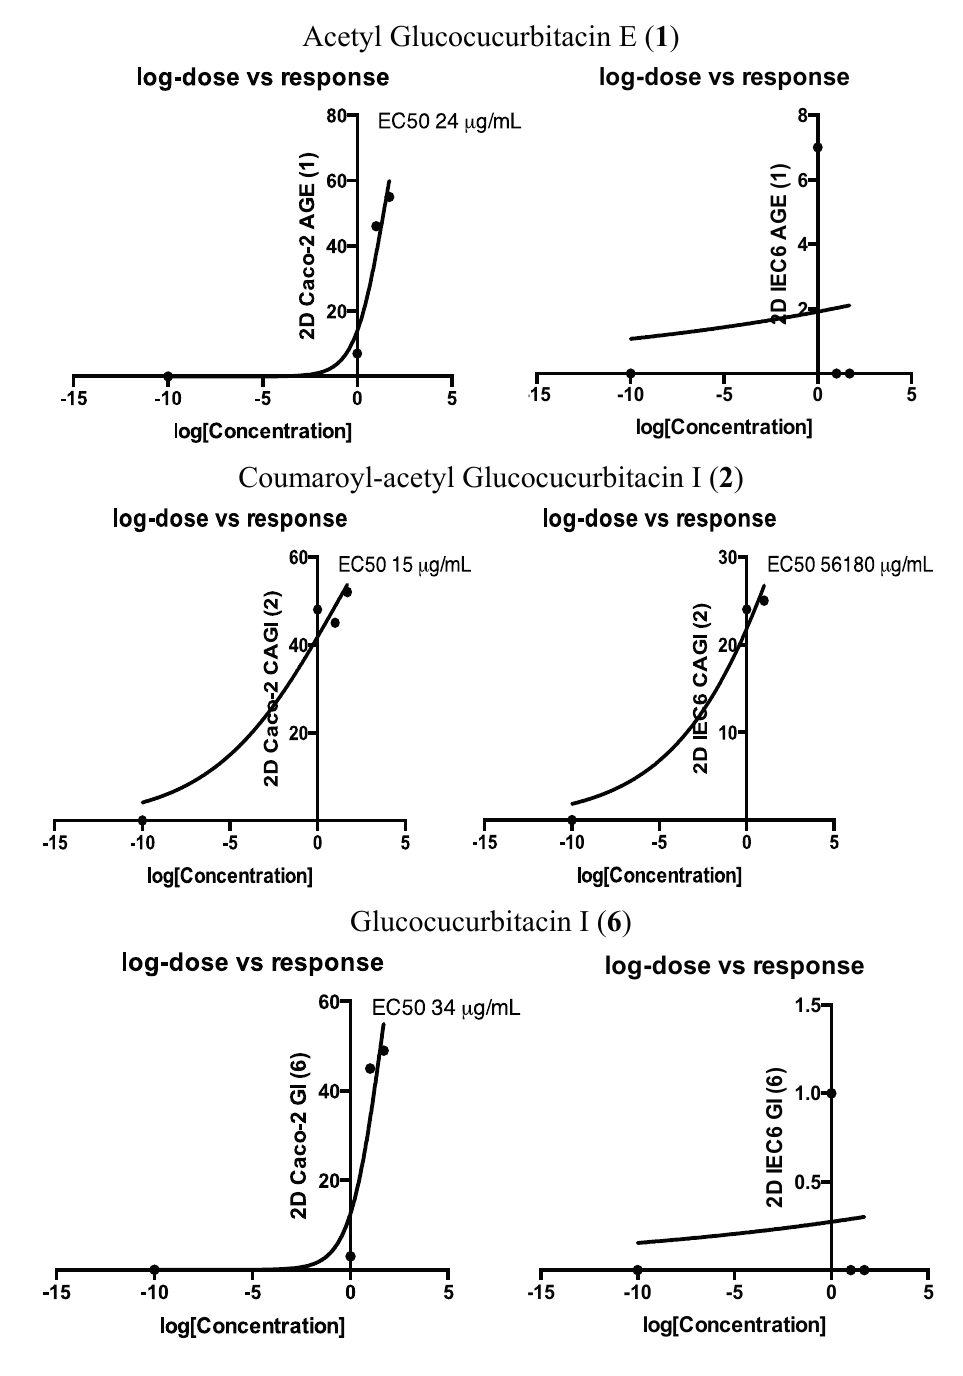
Figure 3. Log-dose response and EC 50 of compounds 1 , 2 and 6